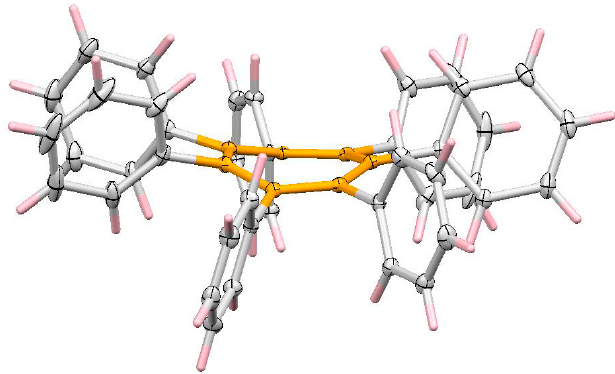
Figure 9. Molecular structure of the nonplanar heptaphenyltropylium cation, C 7 Ph 7+ , 13 .